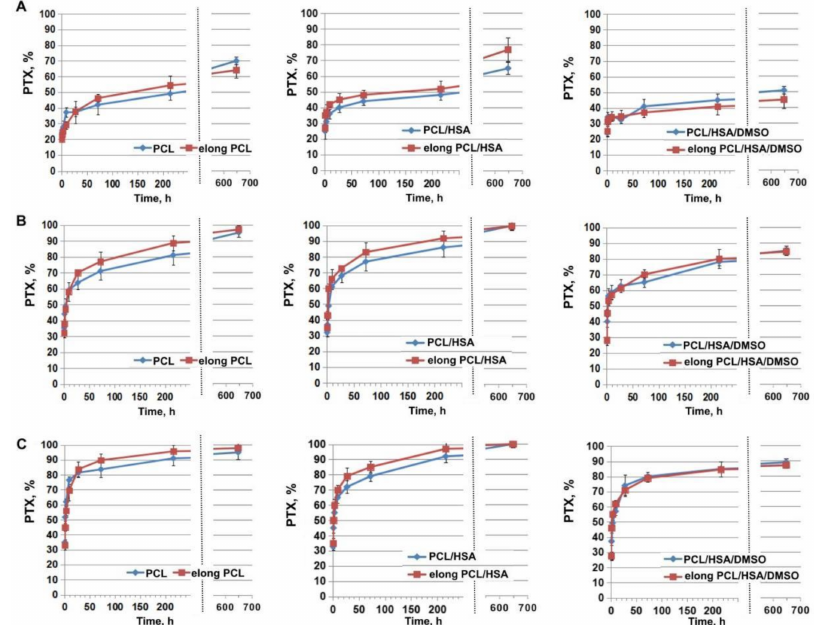
Figure 3. The kinetic curves of PTX release from intact and elongated matrices. The illustrations show incubation of the matrices in ( A ) PBS without medium replacement; ( B ) blood plasma (BP) without medium replacement; ( C ) BP with medium replacement. Table 3. A comparison of release curves using fit factors f1 and f2. A comparison is given of the kinetic curves of SRL release from the intact and the twofold elongated